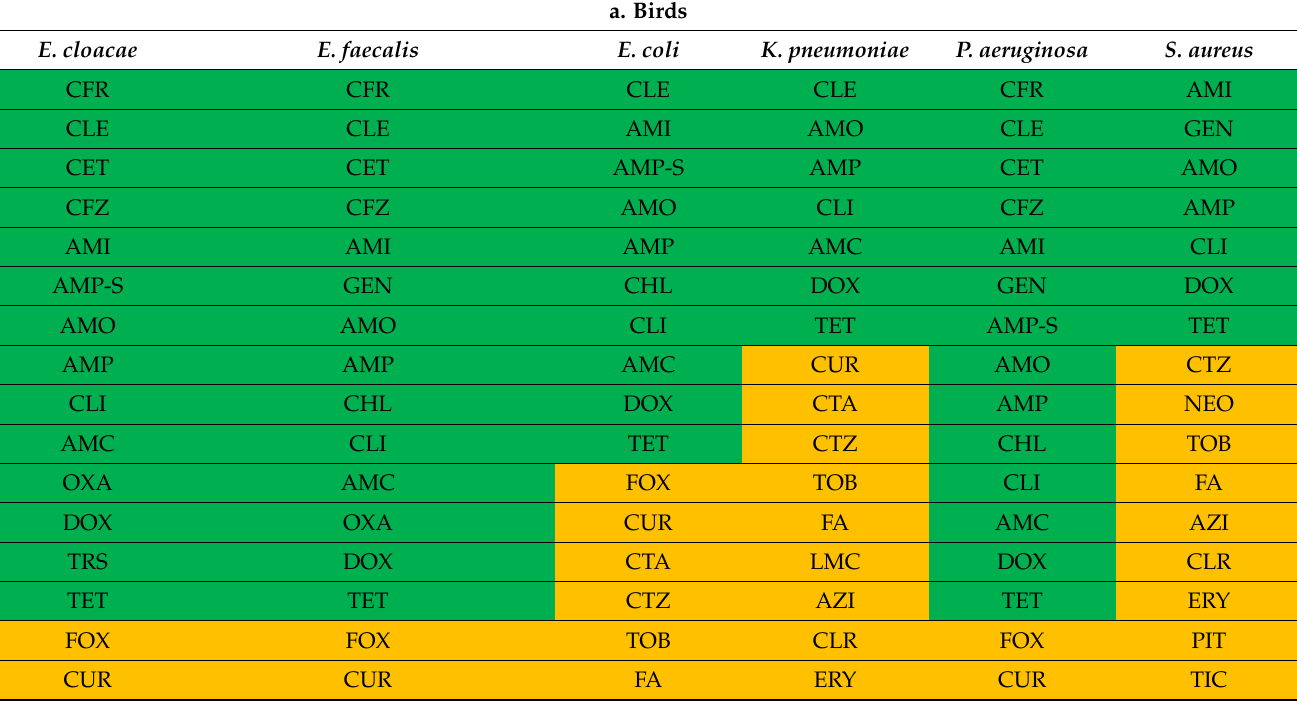
Figure A4. Proportion of susceptible (S), susceptible—increased exposure (I), and resistance (R) bacterial strains in reptiles. Table A1. Antimicrobial resistance of the principal bacteria isolated from the three animal classes and their AWaRe classification: Access (green), Watch (yellow), Reserve (red).